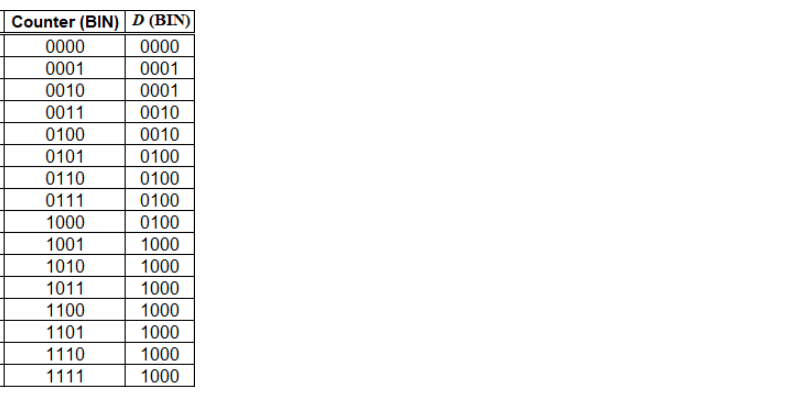
Figure 11. Selected simulation results illustrating the performance of the circuit shown in Figure 1: ( a ) signals representing iterations k and the corresponding values of the variable D k (in binary notation), ( b ) supply current, and ( c ) table with states of particular variables. The ‘Counter’ represents the iteration, k